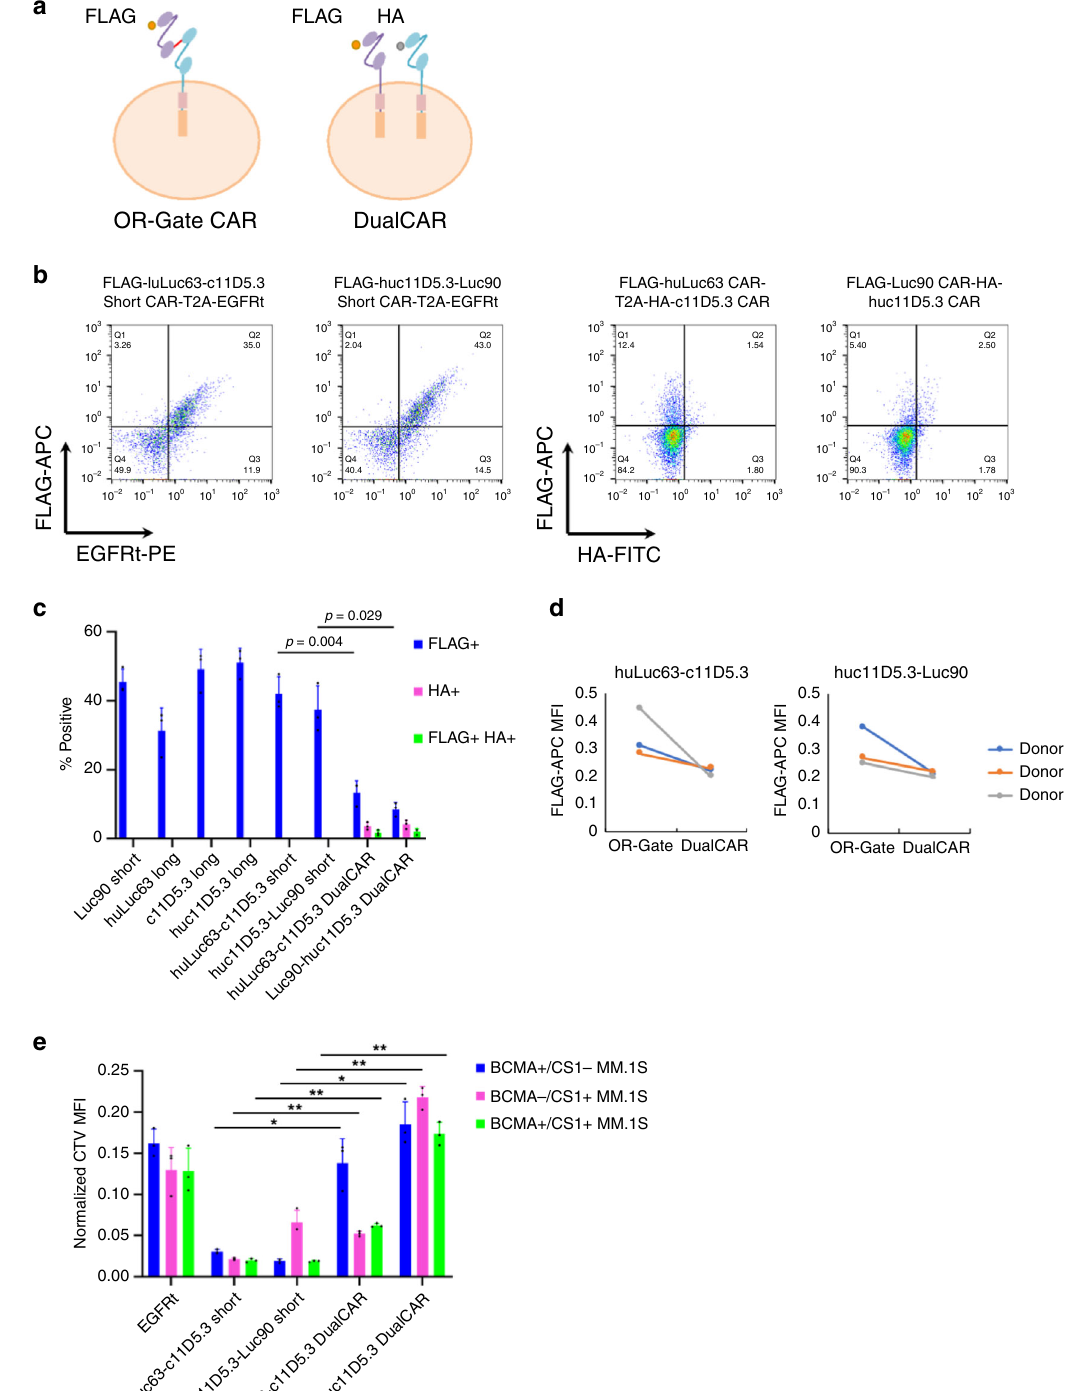
sequence (Supplementary Fig. 4b). Flow-cytometry analysis surface expression, in terms of % CAR + as well as median fl uorescence intensity (MFI) for CAR expression, compared to OR-gate CAR-T cells (Fig. 3b – d). Furthermore, DualCAR-T cells exhibited signi fi cantly weaker T-cell proliferation upon antigen stimulation (Fig. 3e) compared to the corresponding OR-gate CAR-T cells, even when the assay setup was normalized by CAR +